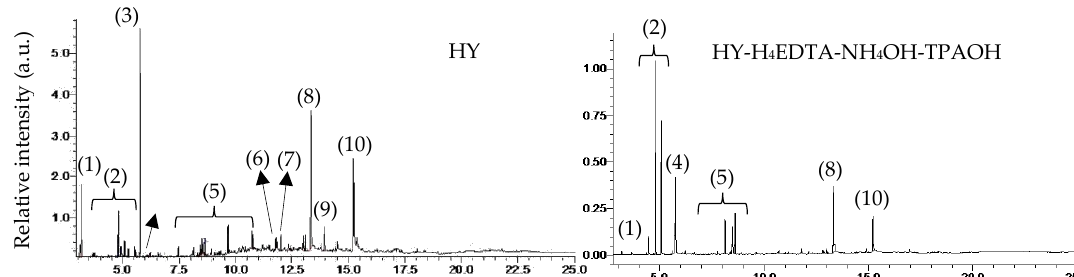
Figure 6. GC-MS analysis of the used HY and HY-H 4 EDTA-NH 4 OH-TPAOH zeolites after 24 h reaction. The coke species were: (1) methoxy species; (2) aromatic compounds; (3) 2,4- dimethylbenzaldehyde; (4) nonanal; (5) C 14 -C 20 alkane; (6) isopropyl myristate; (7) diisobutyl phthalate; (8) methyl palmitate; (9) isopropyl palmitate; (10) methyl stearate.